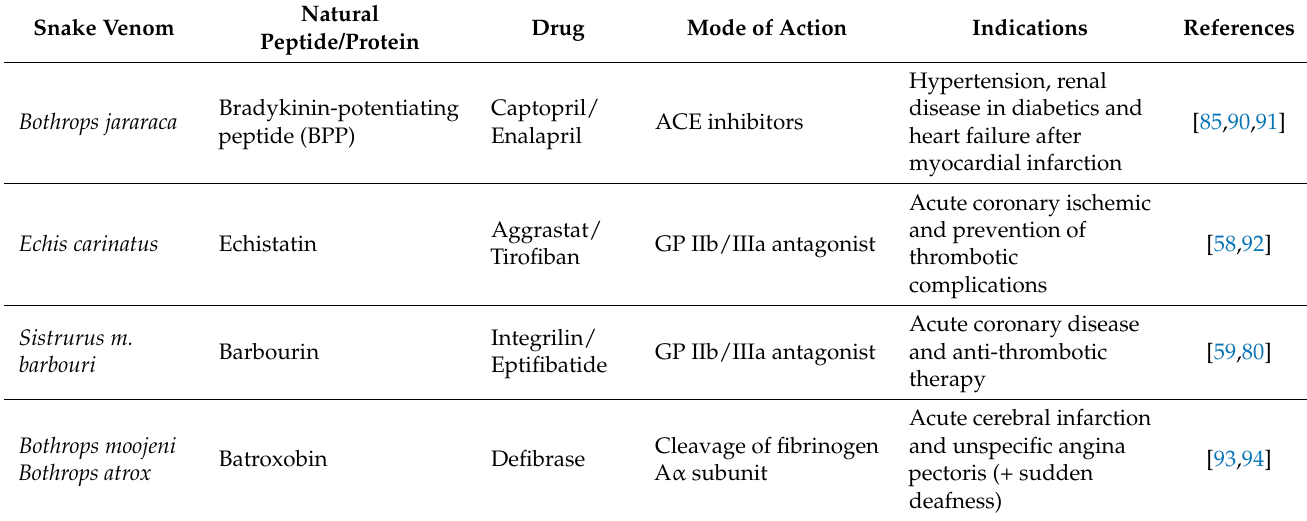
Table 2. Approved snake-venom-based drugs for CVD